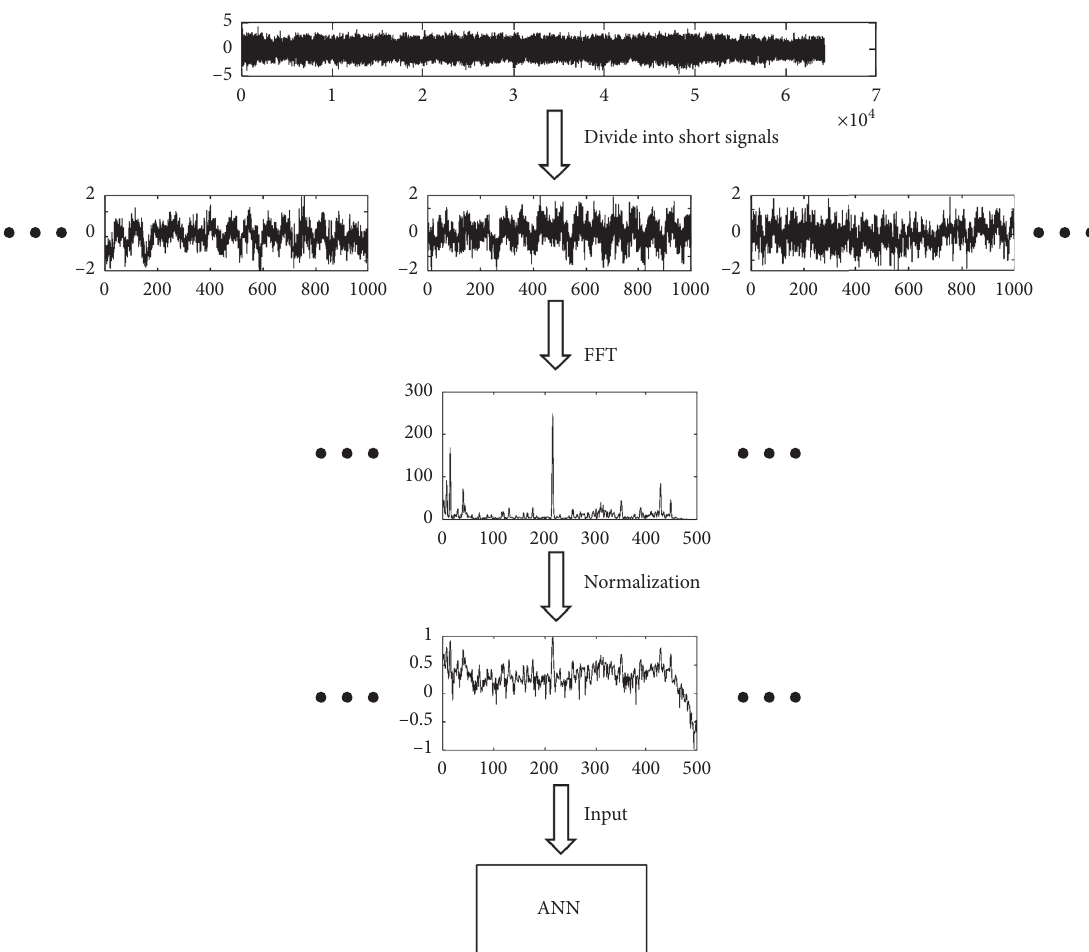
Figure 4: Signal processing.